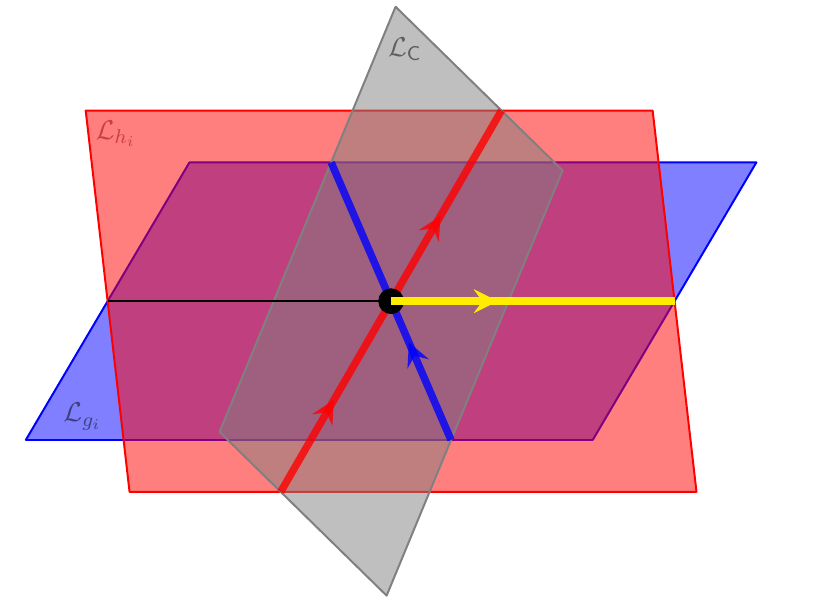
(blue), L (red) h i i C g i